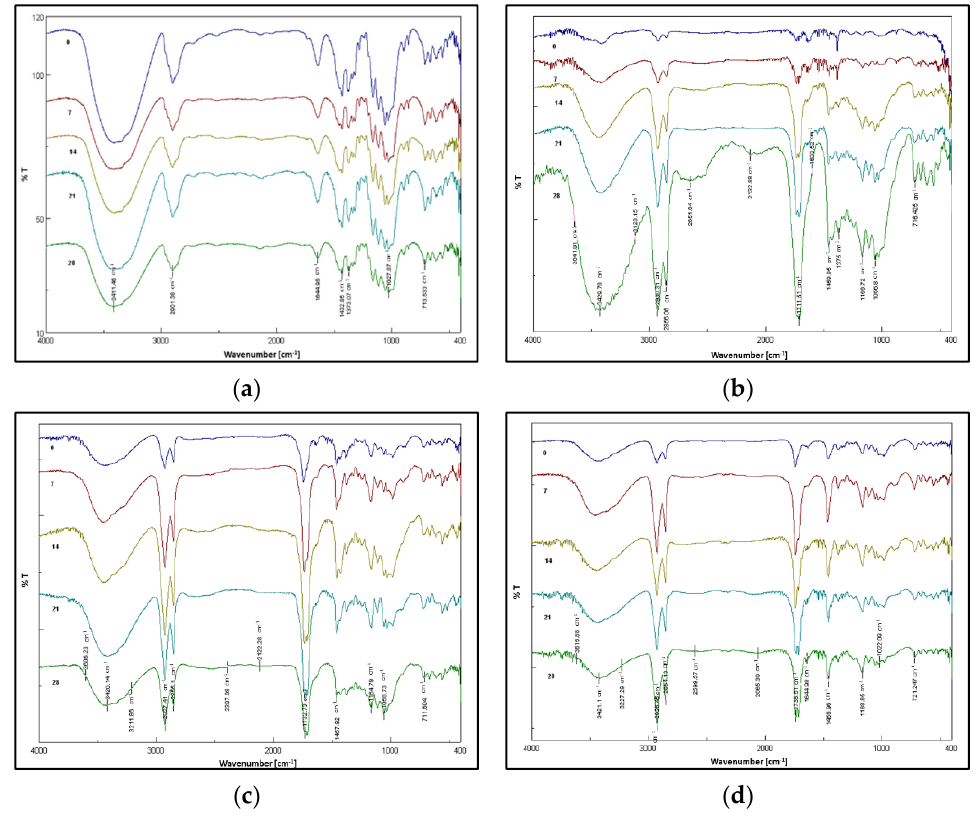
Figure 9. FTIR spectra of the four sets of mock-ups at various ageing stages: ( a ) plain cotton mock-ups; ( b ) cotton mock-ups impregnated with cold-pressed linseed oil; ( c ) cotton mock-ups impregnated with refined linseed oil; ( d ) cotton mock-ups impregnated with stand-oil.